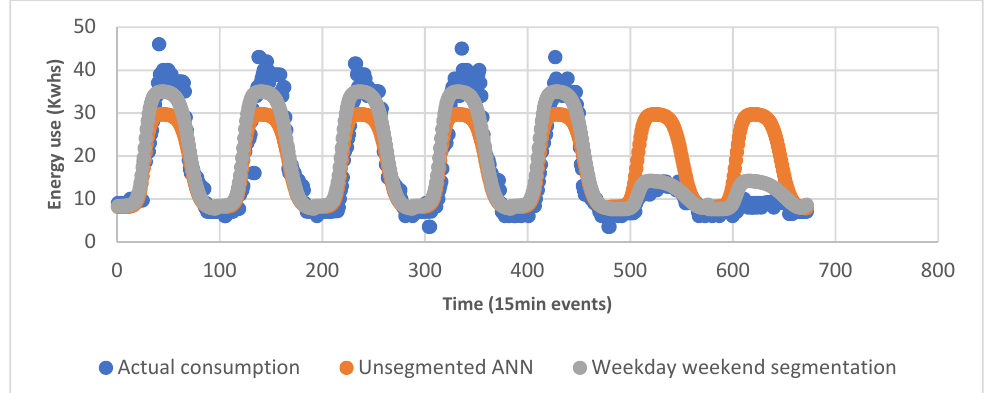
Figure A8. The first ANN predicted week of autumn.